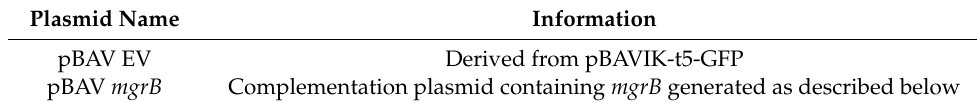
Table 2. Plasmids used in this study.